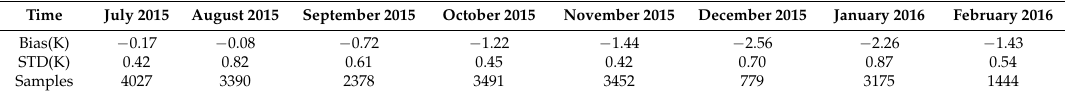
Table 1. Calibration biases of FY-2G IR2 band (@290 K) between July 2015 and February 2016.